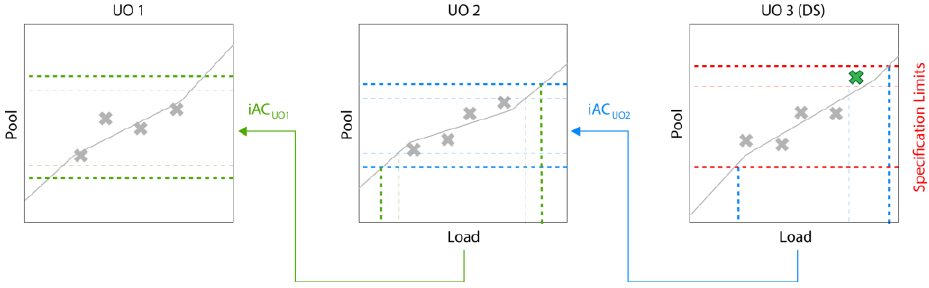
Figure 4. The effect of adding an additional data point on the iAC calculation.